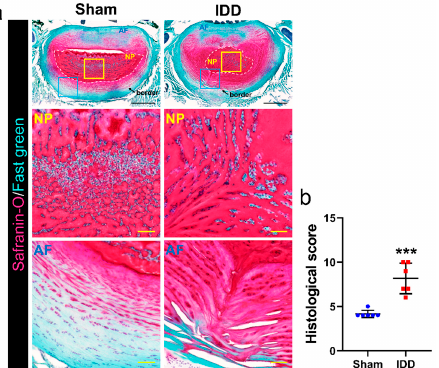
Figure 2. Histological analysis of the IDD model. ( a ) Representative images of Safranin-O/fast green staining in the L5/6 disk of the sham and IDD groups. The white dotted line indicates the NP region of the disc. Magnified images of the NP and AF regions are outlined in yellow and blue boxes, respectively. Black scale bar = 1000 µm, Yellow scale bar = 200 µm; ( b ) Quantification of histological score for disc degeneration at 4 weeks in the sham and IDD groups ( n = 6/group). Data are expressed as the mean ± SEM. Significant differences indicated as *** p < 0.001 vs. sham group were analyzed via unpaired t-tests with Welch’s correction. AF, annulus fibrosus; IDD, intervertebral disc degeneration; NP, nucleus pulposus; SEM, standard error of the mean .